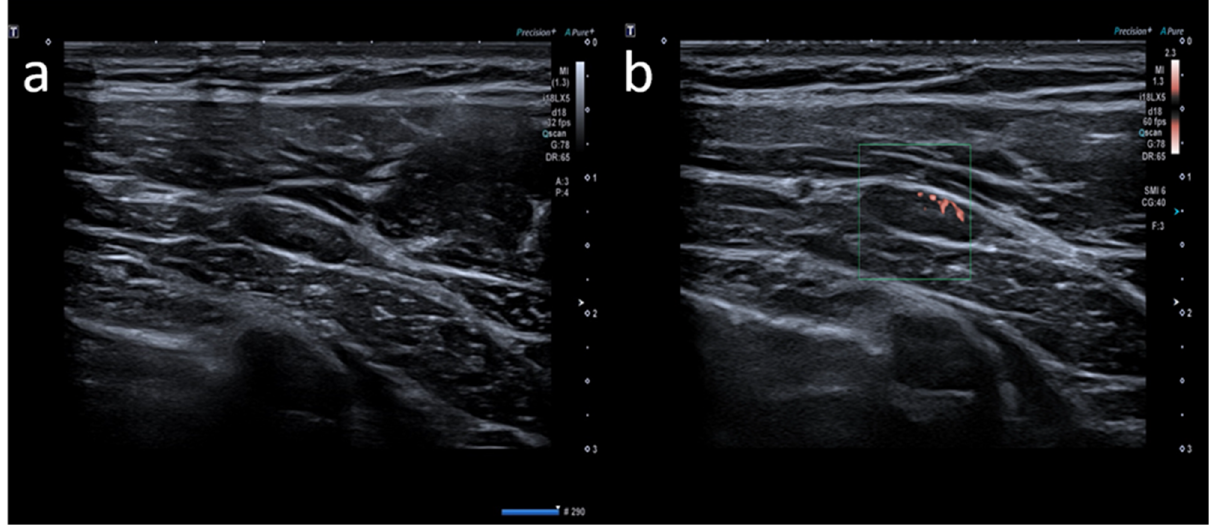
Figure 3. A 23-year-old female with pectoral swelling noted three days after receiving the first dose of the Pfizer COVID- 19 vaccine in her left deltoid muscle. ( a ) B-mode sonogram image shows pectoral intramuscular ovalar hypoechoic lymph node with symmetric cortical thickening and hilum evidence. ( b ) SMI image shows central and peripheral vascularization.